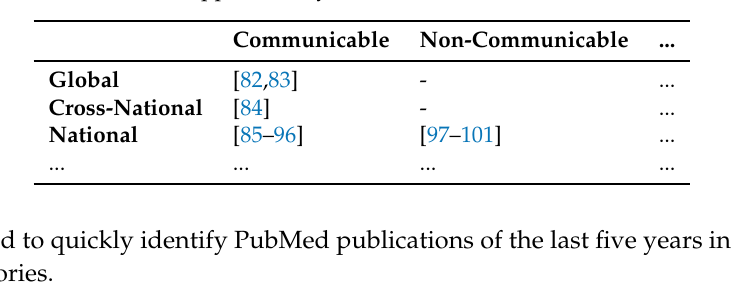
Table 2. Example of a classified list of references using the introduced spatial and health categories. The full list can be found in the Supplementary Materials Table